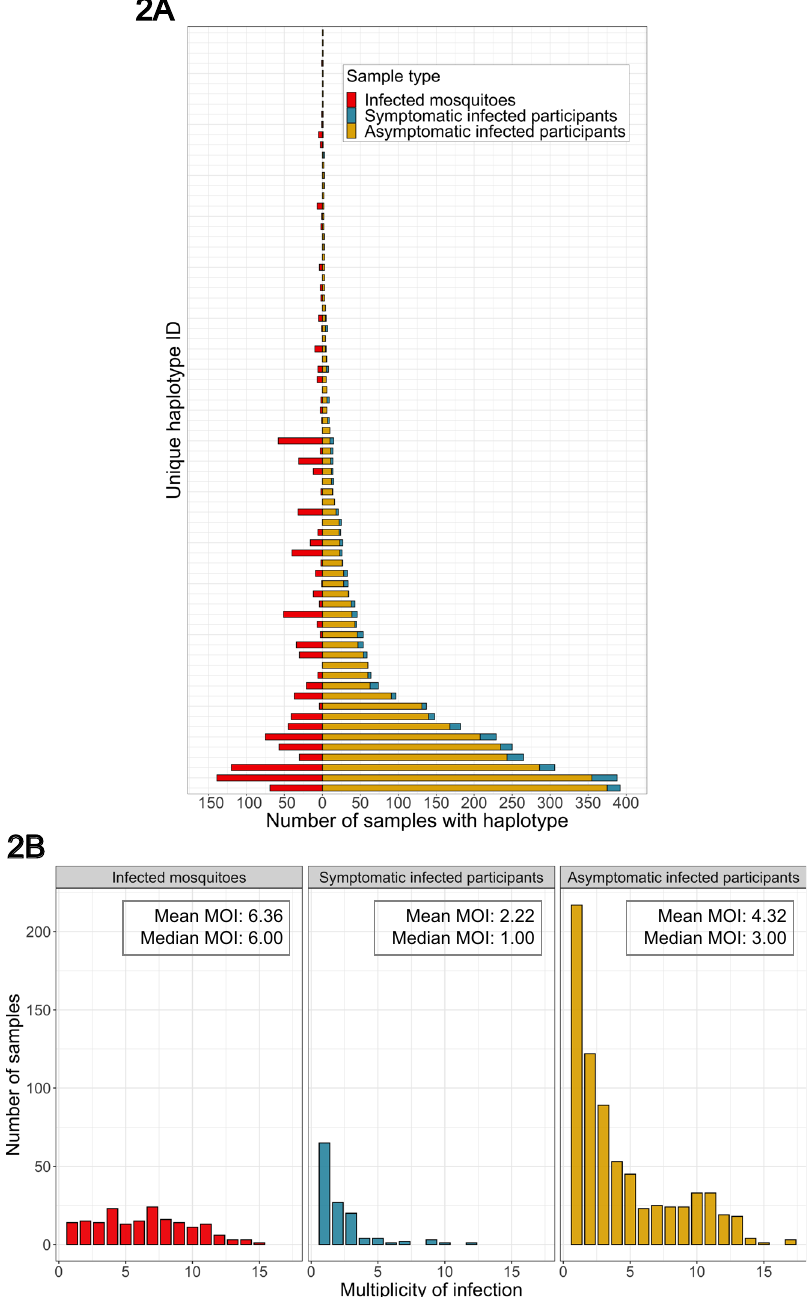
Fig. 2 Distributions of pfcsp haplotypes across and within participants and mosquitoes. A Distribution of the 75 most common pfcsp haplotypes in mosquitoes (red), symptomatic infections (blue), and asymptomatic infections (yellow), ordered vertically by the number in the asymptomatic infections. A full plot of all 229 pfcsp haplotypes and a table of the counts for these haplotypes across sample types is in the supplement (S12 Fig and Table S6). B Multiplicity of infection (MOI) based on observed number unique pfcsp haplotypes in each mosquito abdomen (red), symptomatic infection (blue), and asymptomatic infection